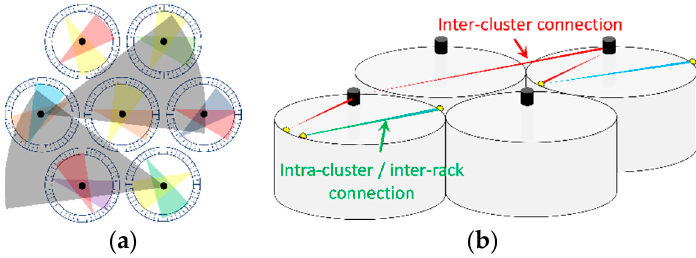
Figure 8. Proposed DC clusters and server orientations. ( a ) From top; ( b ) Inter-cluster and inter-rack FSO links.